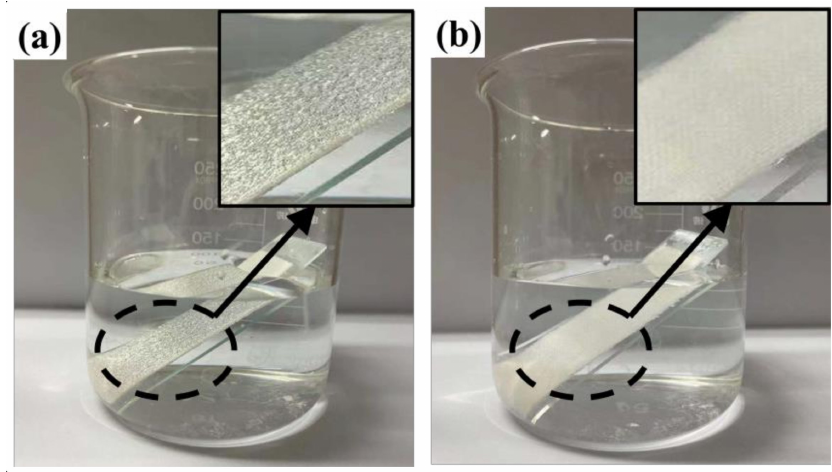
Figure 4. Finished ( a ) and unfinished ( b ) cotton fabric immersed in water.